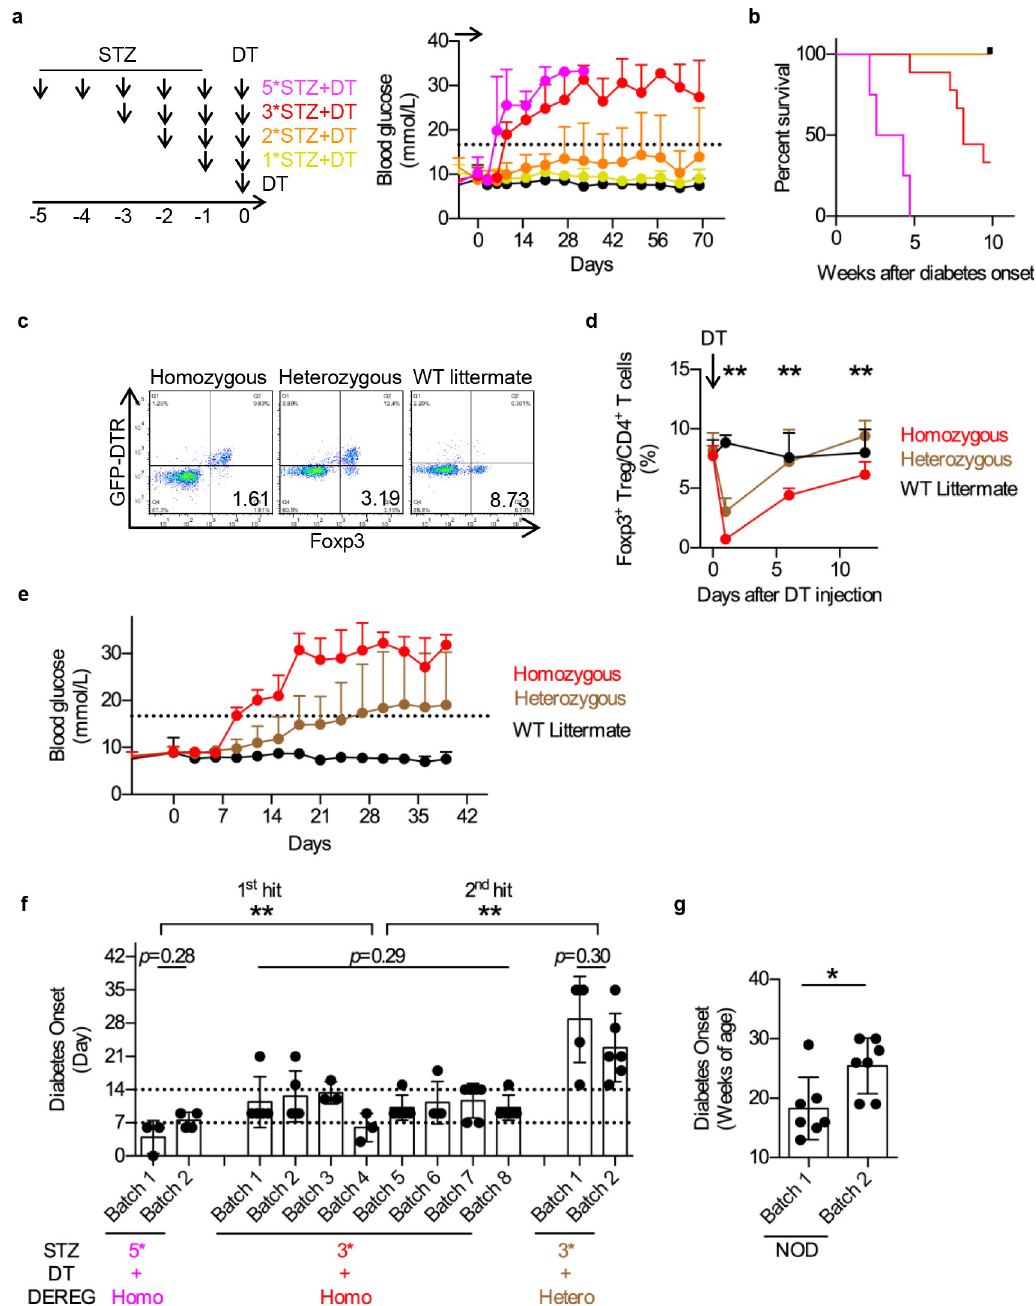
Fig 4. Manipulations of each hit tuned diabetes progression. a . Pancreas damage severity affected diabetes progression. Left, multiple low-dose STZ schedules. In addition to standard 3 � STZ+DT schedule (Red), stronger (5 � STZ+DT, magenta) or weaker (2 � STZ+DT, orange, or 1 � STZ+DT, yellow) STZ damage schedules were analyzed. Right, blood glucose fluctuation after model setup. DT was given as control (Black). Arrow represents model setup from day -5 to day 0. Dash line represents blood glucose at 16.7 mmol/L. n = 5. N = 3. b . Survival after diabetes onset. Color codes as in 4a. n = 5. c-e . Autoimmune severity affected diabetes progression. c . Genotype of homozygous and heterozygous DEREG mice. Wildtype littermates were added as negative control. Numbers showed Foxp3 + GFP-DTR - Treg percentage in CD4 + spleno-T cells, analyzed by intracellular staining. n = 3. N = 3. d. Foxp3 + Treg dynamic after DT depletion of DTR + Tregs. Statistical significance was analyzed between homozygous (Red) and heterozygous (Brown) groups at day 1, 6 and 12. n = 6. N = 3. e . Blood glucose fluctuation after model setup in homozygous or heterozygous DEREG mice. Blood glucose over 16.7 mmol/L was identified as hyperglycemia (Dash line). Statistics between Homozygous and Heterozygous mice were shown for each testing day. n = 6. N = 3. f Disease onset date of 1 st hit or 2 nd hit